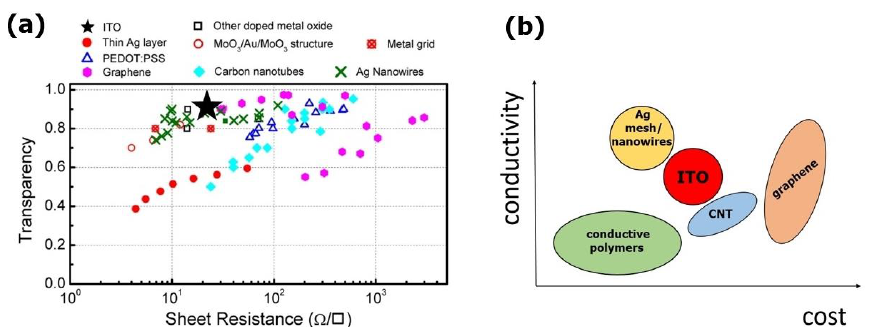
Figure 19. ( a ) Transmittance versus sheet resistance performance of a range of single alternative materials proposed to replace ITO; status 2014. Composite materials are not considered in this graph. (Reproduced by permission from [26]). ( b ) A rough placement of different material groups as alternatives to ITO electrodes, showing conductivity versus cost. The higher the conductivity, the lower the sheet resistance, but also the lower the transmittance generally as well.